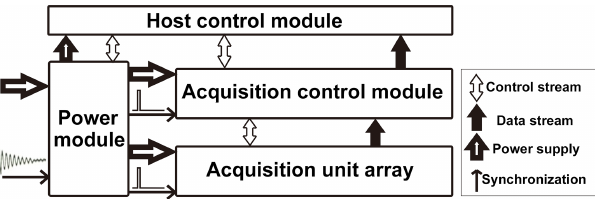
Figure 2. Structure diagram of